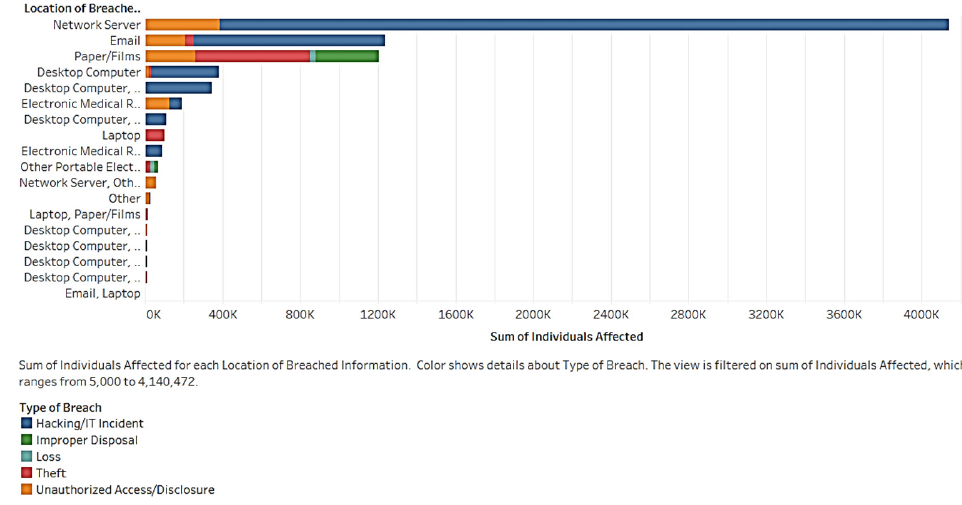
Figure 4. Data breach location vs. number of data breach records.